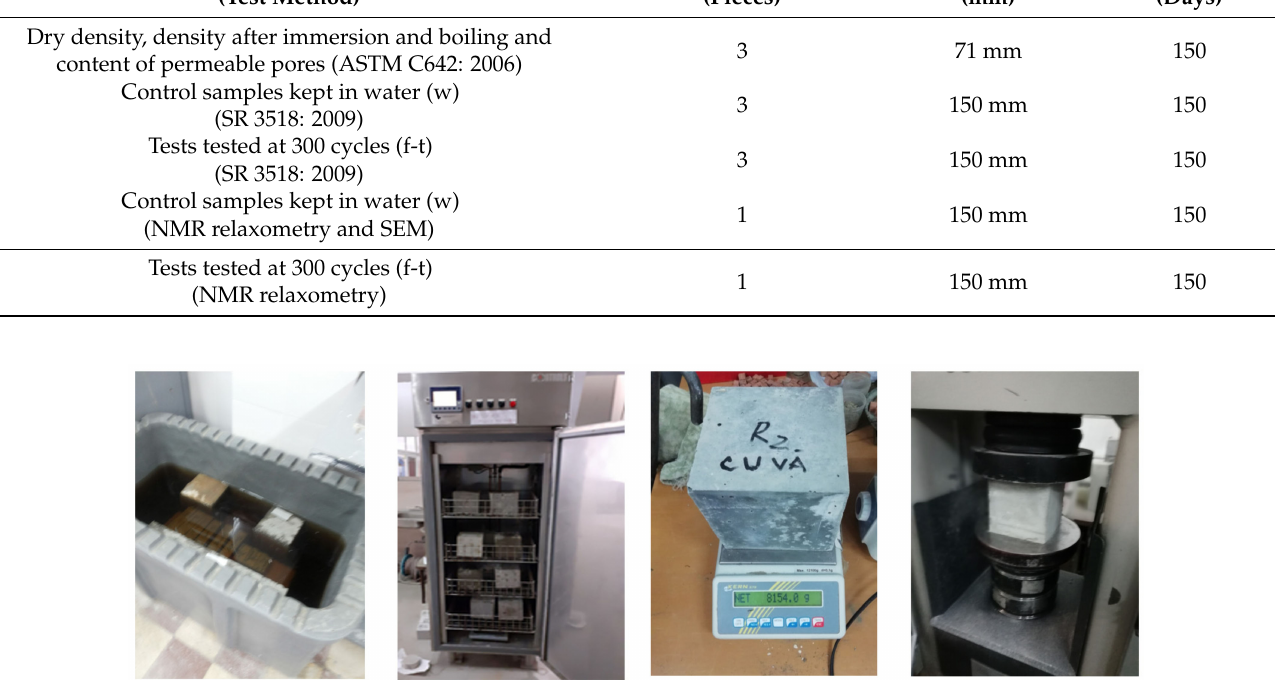
Figure 1. Control specimens kept in water and specimens underwent the freeze–thaw test (150 mm × 150 mm × 150